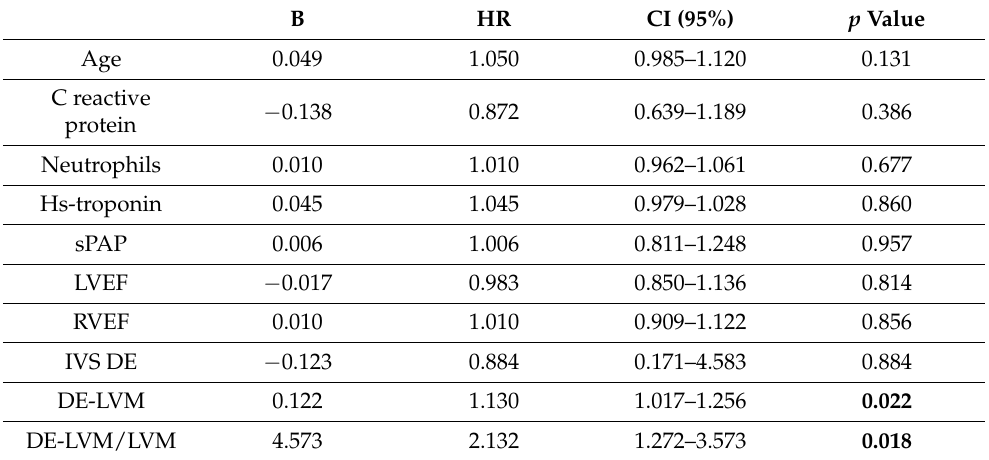
fraction; sPAP, systolic pulmonary artery pressure.